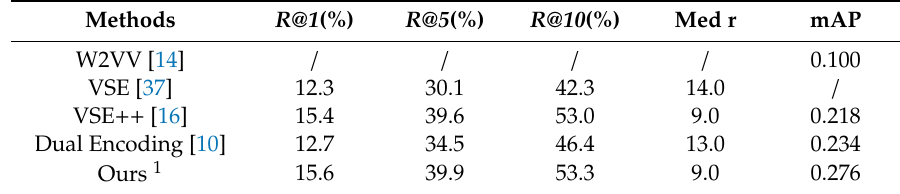
Table 2. State-of-the-art on MSVD dataset.